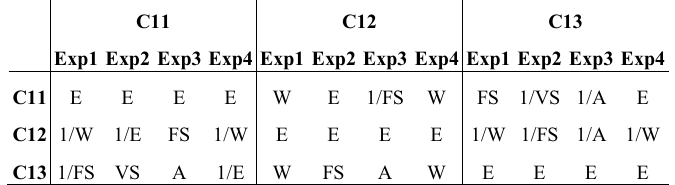
Table 9: Expert Evaluations of sub-criteria (C11-C13) with respect to Environmental Factors